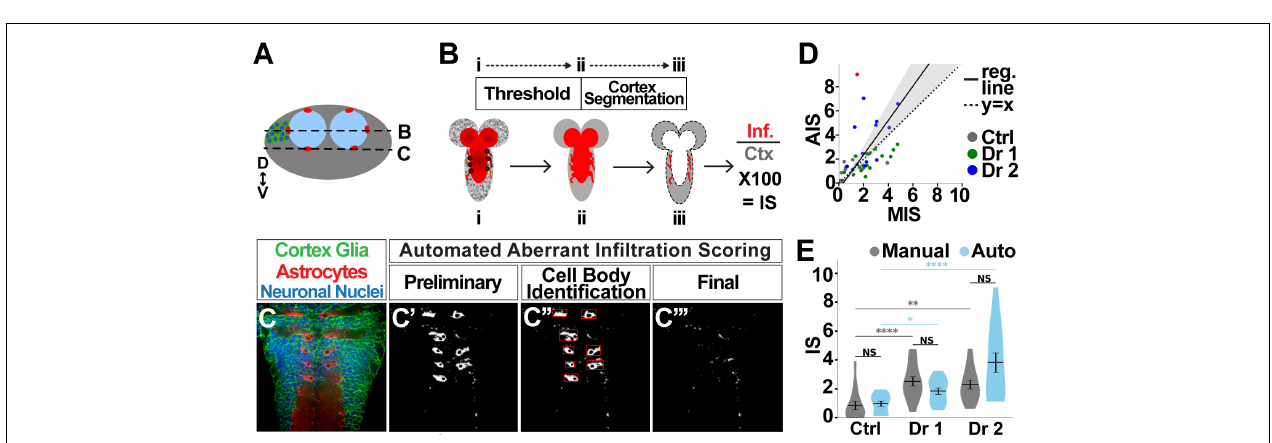
FIGURE 5 | Automated quantification of astrocyte infiltration. (A) Cross section of the VNC depicting the location of astrocyte cell bodies, as well as the location of longitudinal sections shown in (B,C) . (B) Images were taken in longitudinal planes. The astrocyte channel was then thresholded, and the area of overlap between astrocytes and the cortex region was quantified as the infiltration score (IS). (C) Astrocyte cell bodies reside in the cortex under normal conditions (C’) , but were identified (C”) and excluded from the quantification to identify only aberrant cortex infiltration (C”’) . (D) Manual vs. automatic (auto) scores significantly correlate (95% confidence interval depicted by gray shaded area), with control (gray), driver 1 (green), and driver 2 (blue), (slope = 1.424, 95% CI [1.076, 1.772], r 2 = 0.22, p < 0.0001, n = 42). Only one point was identified with a difference of greater than 6 (red) between manual and automated scores. (E) There is no significant difference between manual and automated scores for any of the groups. Pairwise comparison using Kruskal–Wallis test. NS p > 0.5 (control p = 0.343, driver 1 p = 0.678, driver 2 p = 0.155). p < 0.001 for Kruskal–Wallis test comparing three groups with same scoring methodology, followed by Dunn post hoc pairwise